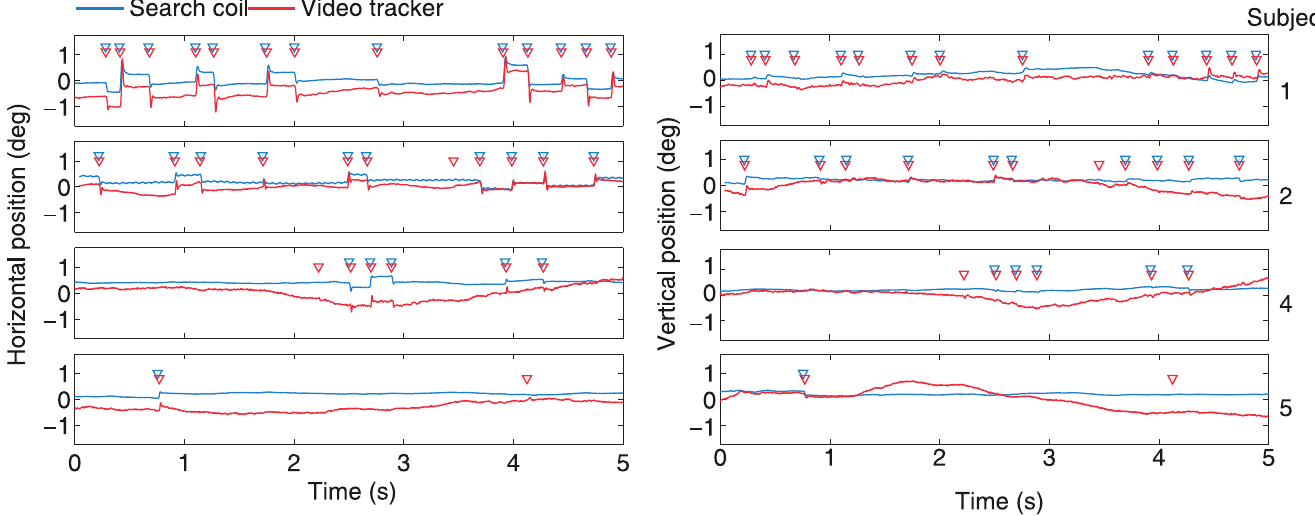
Fig 4. Examples of simultaneous horizontal and vertical eye position traces obtained with the search coil and video tracking, for each participant. Red triangles represent microsaccades detected with the video tracker; blue triangles represent microsaccades detected with the search coil. Note that microsaccades were detected by viewing the vertical and horizontal traces simultaneously. For illustration purposes, a small offset of 0.2 deg has been added to the search coil data.